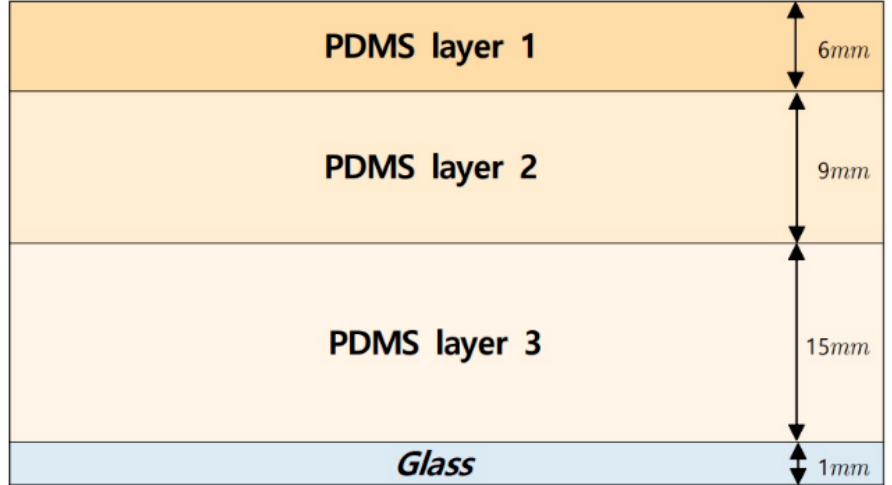
Figure 4. Structure of the multilayer optical waveguide.